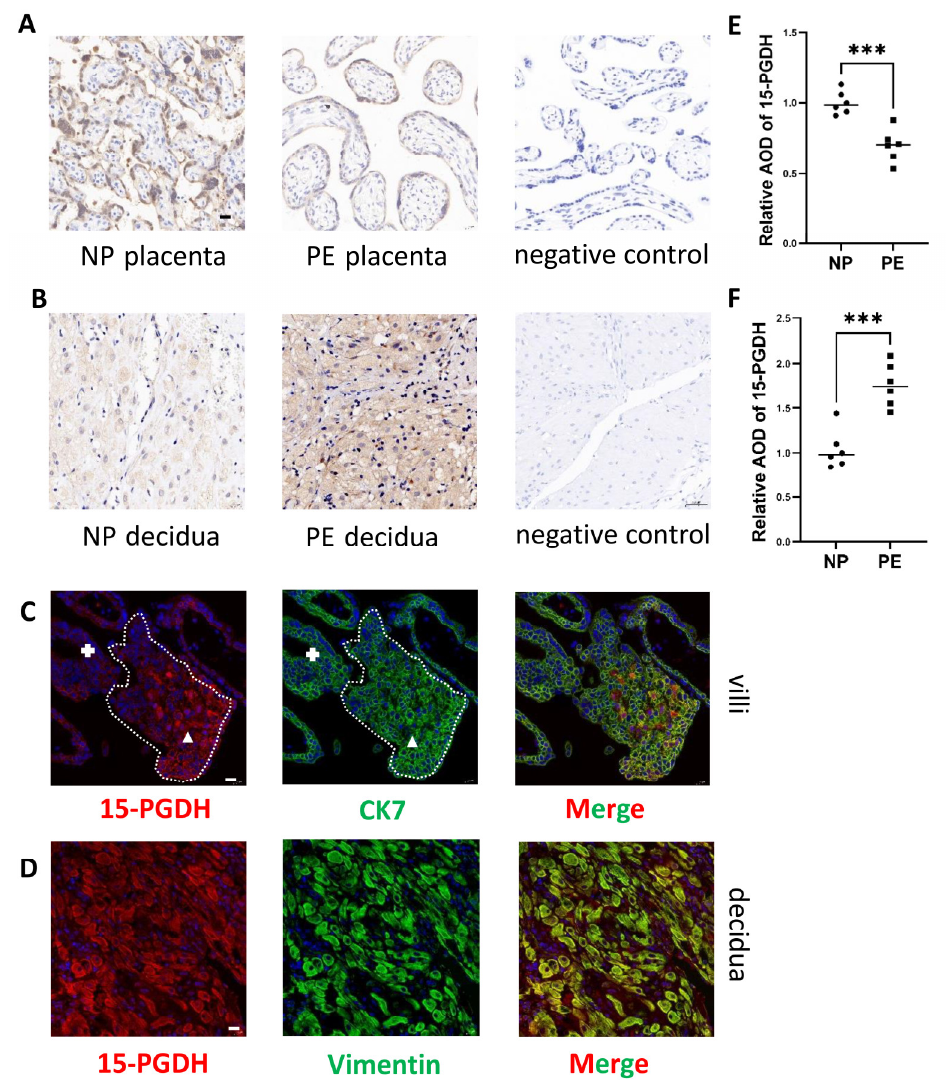
Figure 4. Differential expression of 15-PGDH in PE and the location of 15-PGDH. ( A , B , E , F ) Immuno- histochemical staining showed the relative quantification of 15-PGDH in the placenta and decidua of the PE and NP groups. Brown staining represents the target protein. Scale bar = 20 nm, n = 6, Values are the mean ± SD. *** p < 0.001. n = 6 each. ( C ) Differential expression of 15-PGDH in CTBs and EVTs was identified by immunofluorescence, red: 15-PGDH; green: CK7, Bar = 20 nm. The area of CTBs is labelled with + , and the area of EVTs is labelled with triangles. ( D ) Specific location of 15-PGDH in DSCs was identified by immunofluorescence, red: 15-PGDH; green: vimentin, Bar = 20 nm.